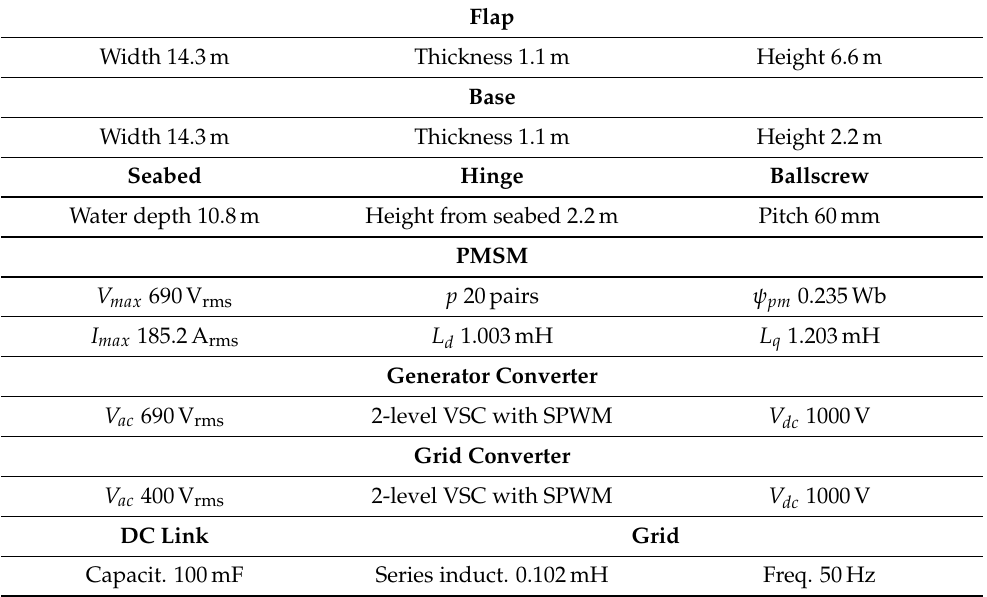
Table 1. Parameters of the offline model